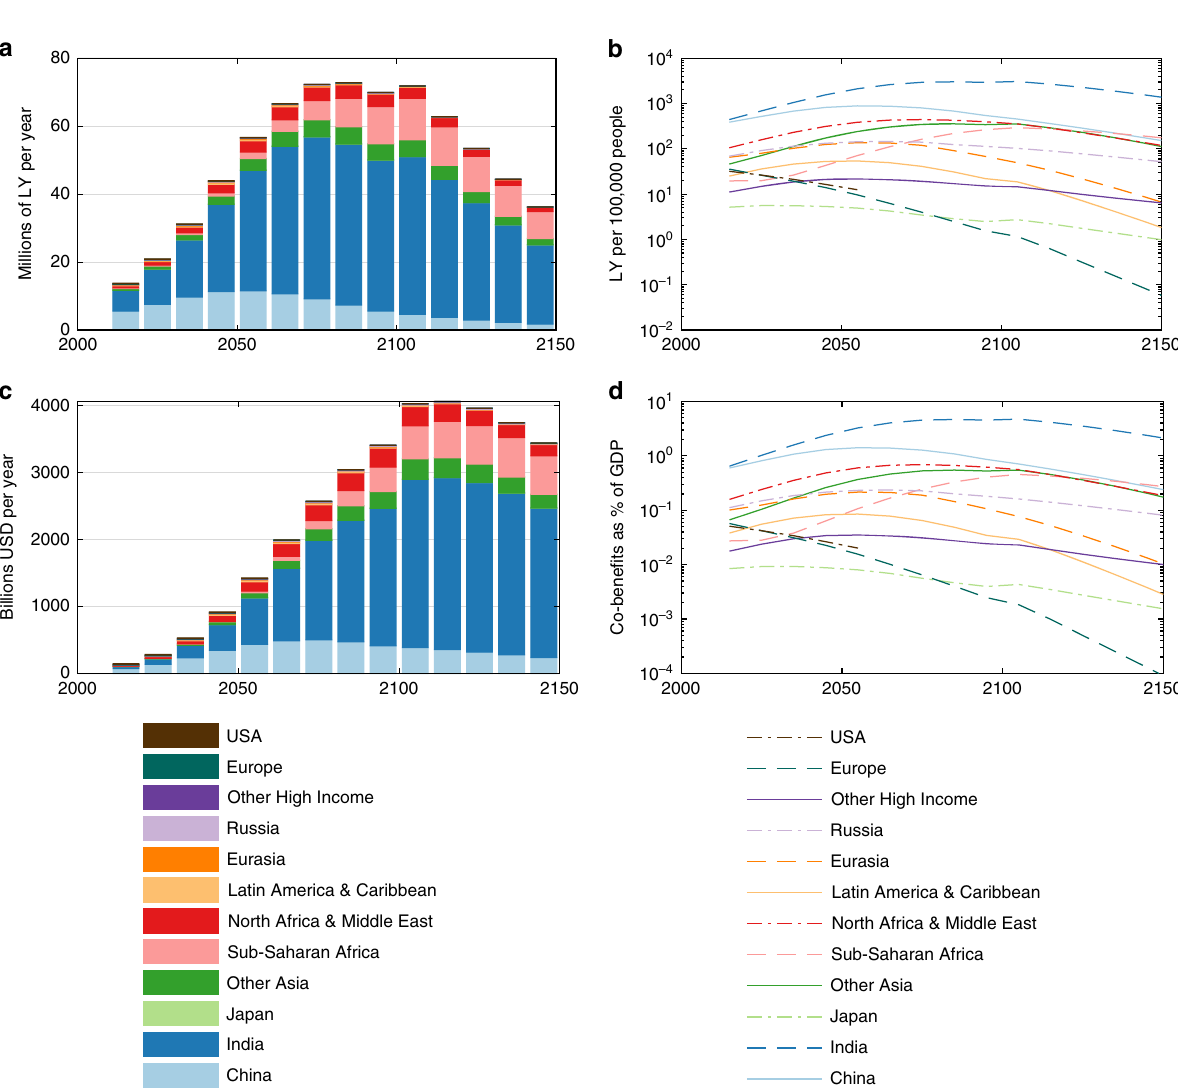
Fig. 3 Health bene fi ts of carbon mitigation. Life-years gained a overall and b per 100,000 population by region from the air quality improvements associated with the optimal decarbonization in RICE + AIR. c , d show the resulting monetized bene fi ts in total, and as a percent of GDP, respectively. Note that if a region ’ s PM 2.5 exposure (concentration) drops below 5.8 µ g/m 3 , health bene fi ts no longer accrue — this threshold assumption is common in